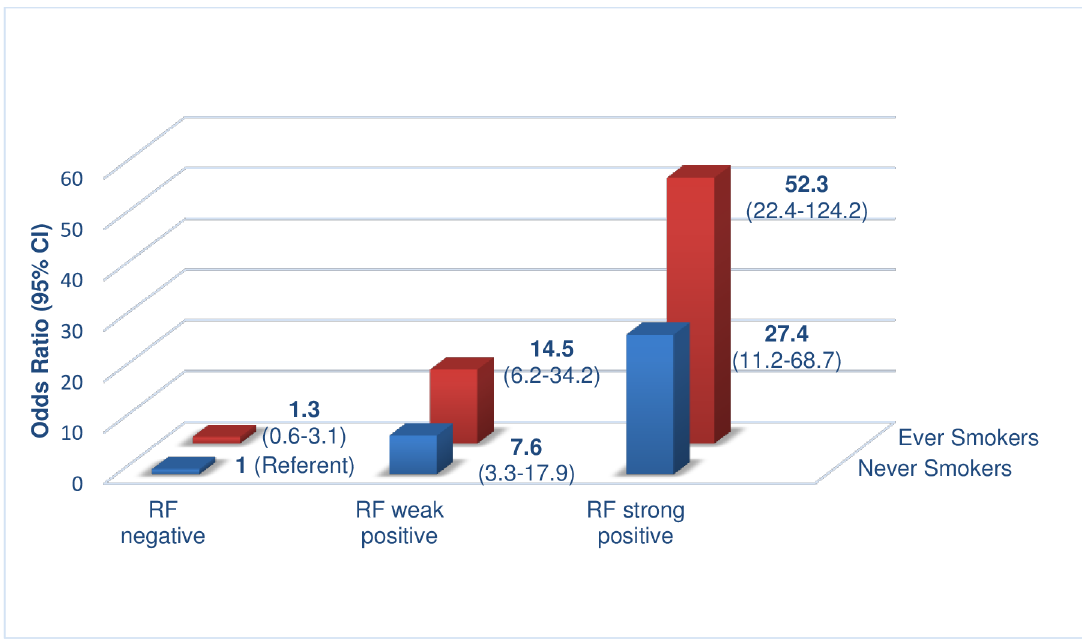
Fig 1. Odds ratio risk of ACPA positivity in